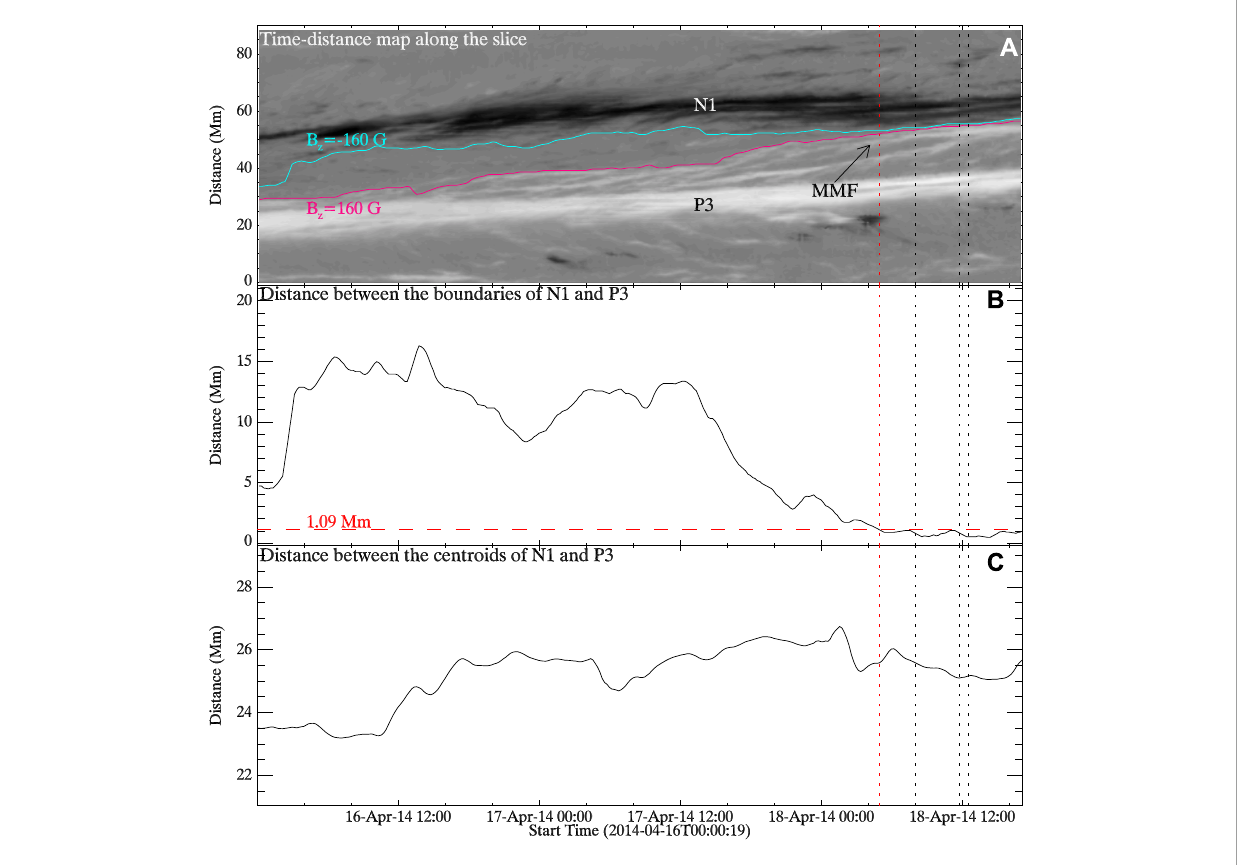
FIGURE 4 (A) Time–distance map of B z along the slice (shown as a green line Figure 3F ). The cyan and magenta curves are the contour lines of −160 G and 160 G drawn from the map, respectively, outlining the inner boundaries of the polarities N1 and P3. The black arrow indicates the moving magnetic features streaming away from P3. The red vertical line marks the time when the distance between the inner boundaries of polarities P3 and N1 drops below the width of three pixels (1.09 Mm). The three black vertical lines indicate the start timings of the first precursor flaring, the second precursor flaring, and the M7.3-class flare, respectively. (B) Distance between the inner boundaries of the polarities P3 and N1. The red horizontal line indicates the distance value of 1.09 Mm. (C) Distance between the flux-weighted centroids of the polarities P3 and N1. The vertical lines in panels (B) and (C) have the same meanings as those in panel (A)